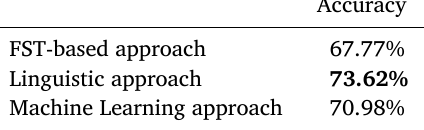
Evaluation results for the out-of-vocabulary word-stress